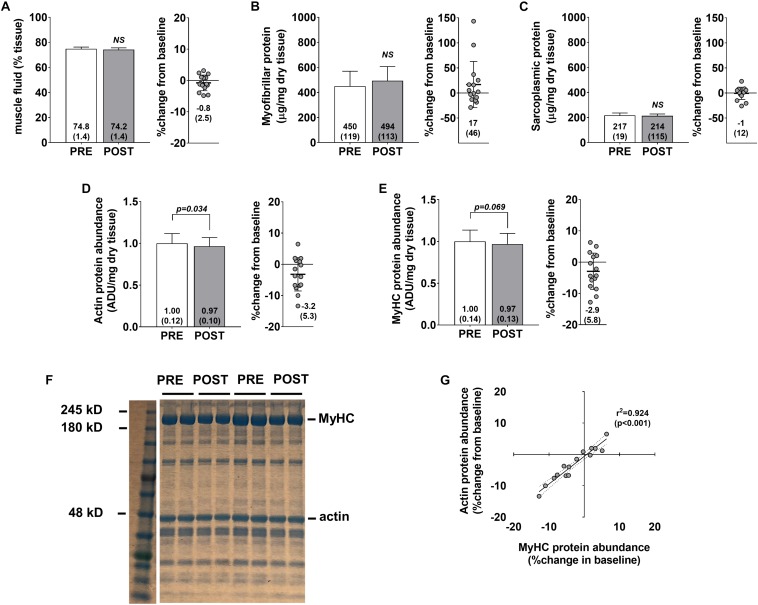
Skeletal muscle protein composition adaptations to high-load training. PRE and POST values for muscle percent fluid (A), myofibrillar protein concentrations (B), sarcoplasmic protein concentrations (C), actin protein abundance (D), and myosin heavy chain protein abundance (E). (F) Demonstrates representative Coomassie PRE and POST images from two participants. (G) Demonstrates the association between actin and myosin heavy chain protein abundance changes from PRE to POST (regression lines are solid and 95% confidence interval bands are dashed).